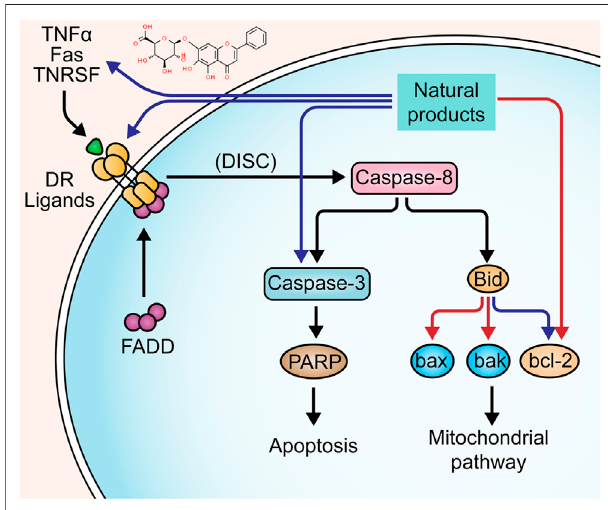
FIGURE1| NaturalproductsmodulateapoptosisofIECsthroughdeath receptors mediated pathway.